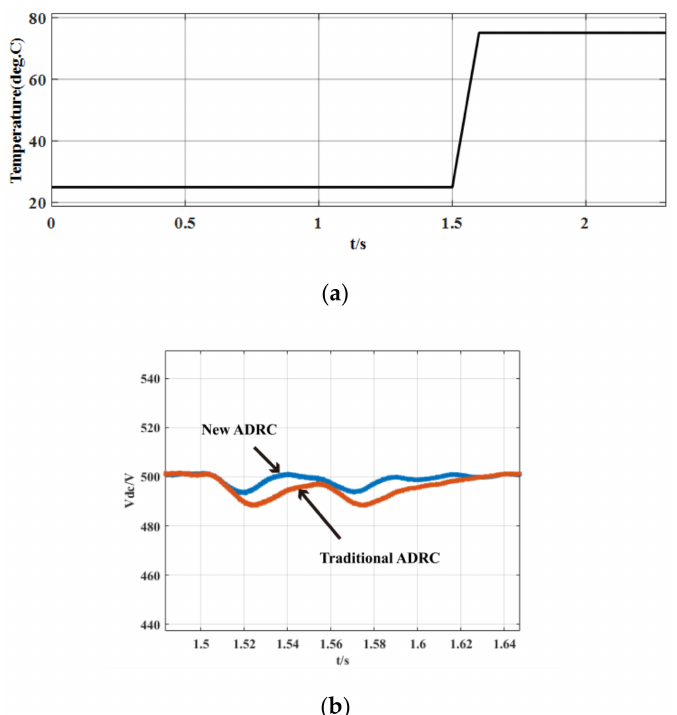
Figure 14. Under the sudden change in light intensity, the voltage waveform comparison between the two control strategies. ( a ) Light intensity change curve; ( b ) The e ff ect of the two control methods when the light intensity drops suddenly; ( c ) The e ff ect of the two control methods when the light intensity rises suddenly.